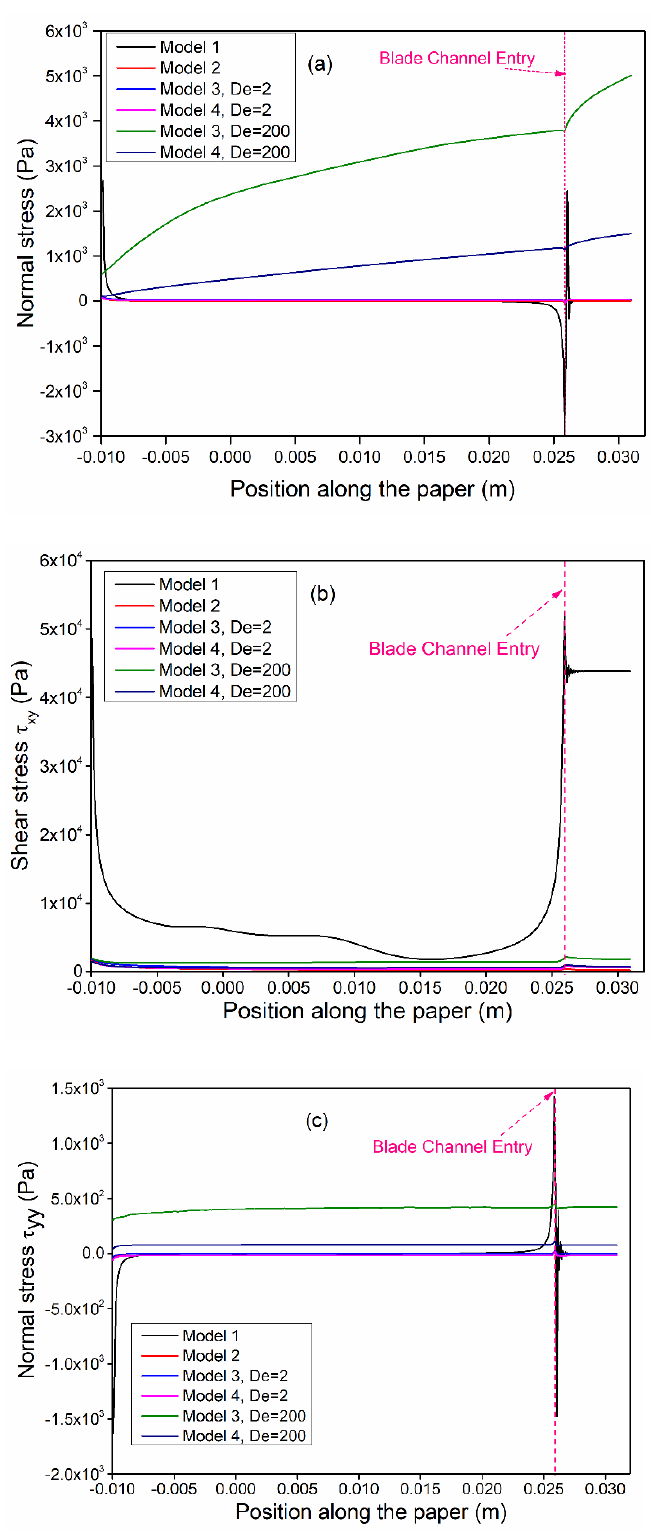
Figure 10. Stresses along the surface of the paper: ( a ) normal stress in the x-direction ( τ xx ), ( b ) shear stress ( τ xy ), ( c ) normal stress in the y-direction ( τ yy ).